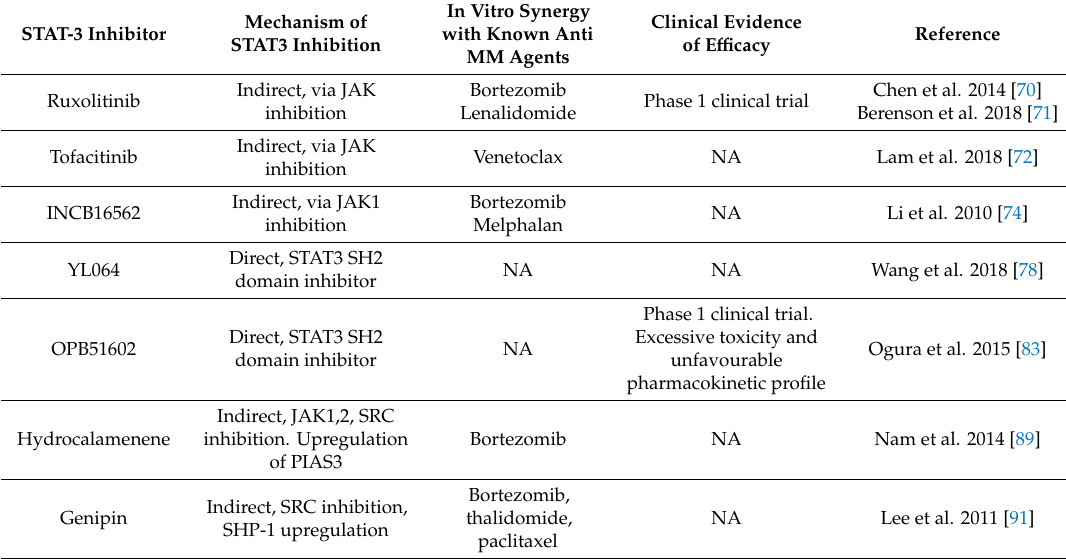
Table 1. Selected STAT3 inhibitors showing in vitro and / or clinical e ffi cacy against multiple myeloma. The mechanism by which STAT3 is inhibited by the compound as well as evidence for in vitro synergy with known anti myeloma therapy and clinical evidence where applicable are presented. STAT3 (Signal transducers and activators of transcription 3), PIAS3 (protein inhibitor of activated STAT3), SHP-1 (SRC homology 2 domain containing phosphatase 1) PTEN (phosphatase and tensin homolog). MM (multiple myeloma), NA (data not available), SH2 (src homology 2), JAK (janus associated kinase), IL-6 (Interleukin